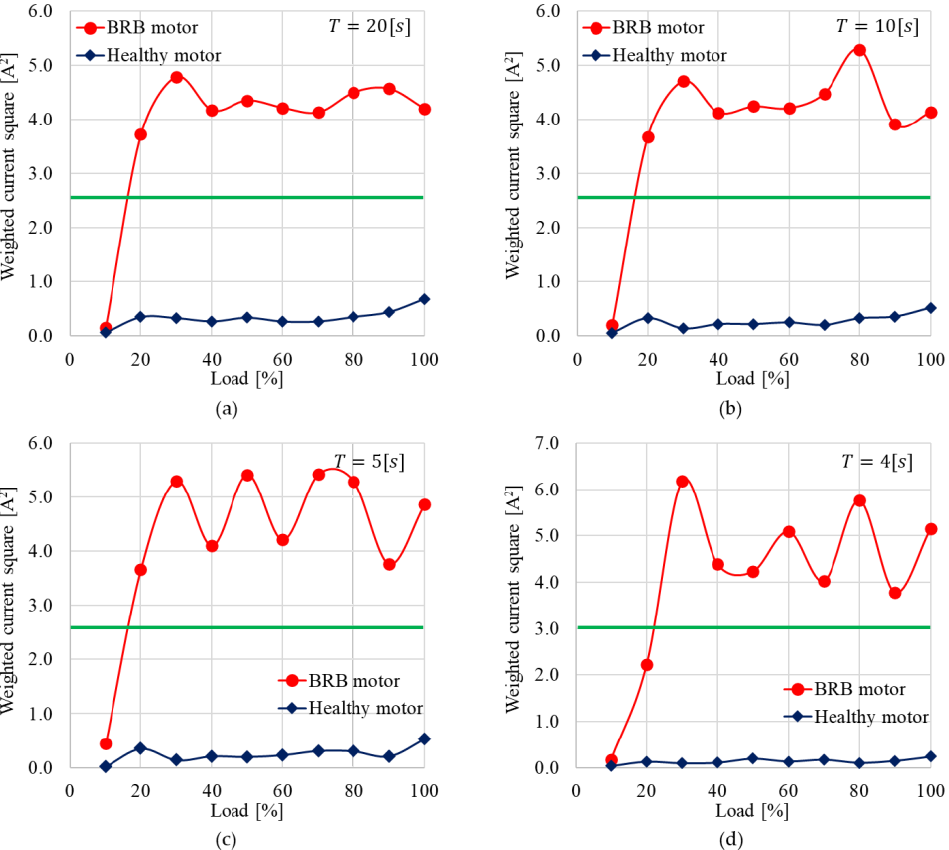
Figure 9. Experimental results of sum of weighted Fourier series coefficients square versus load with BRB fault and healthy motor when ( a ) T = 20 s, ( b ) T = 10 s, ( c ) T = 5 s, and ( d ) T = 4 s.